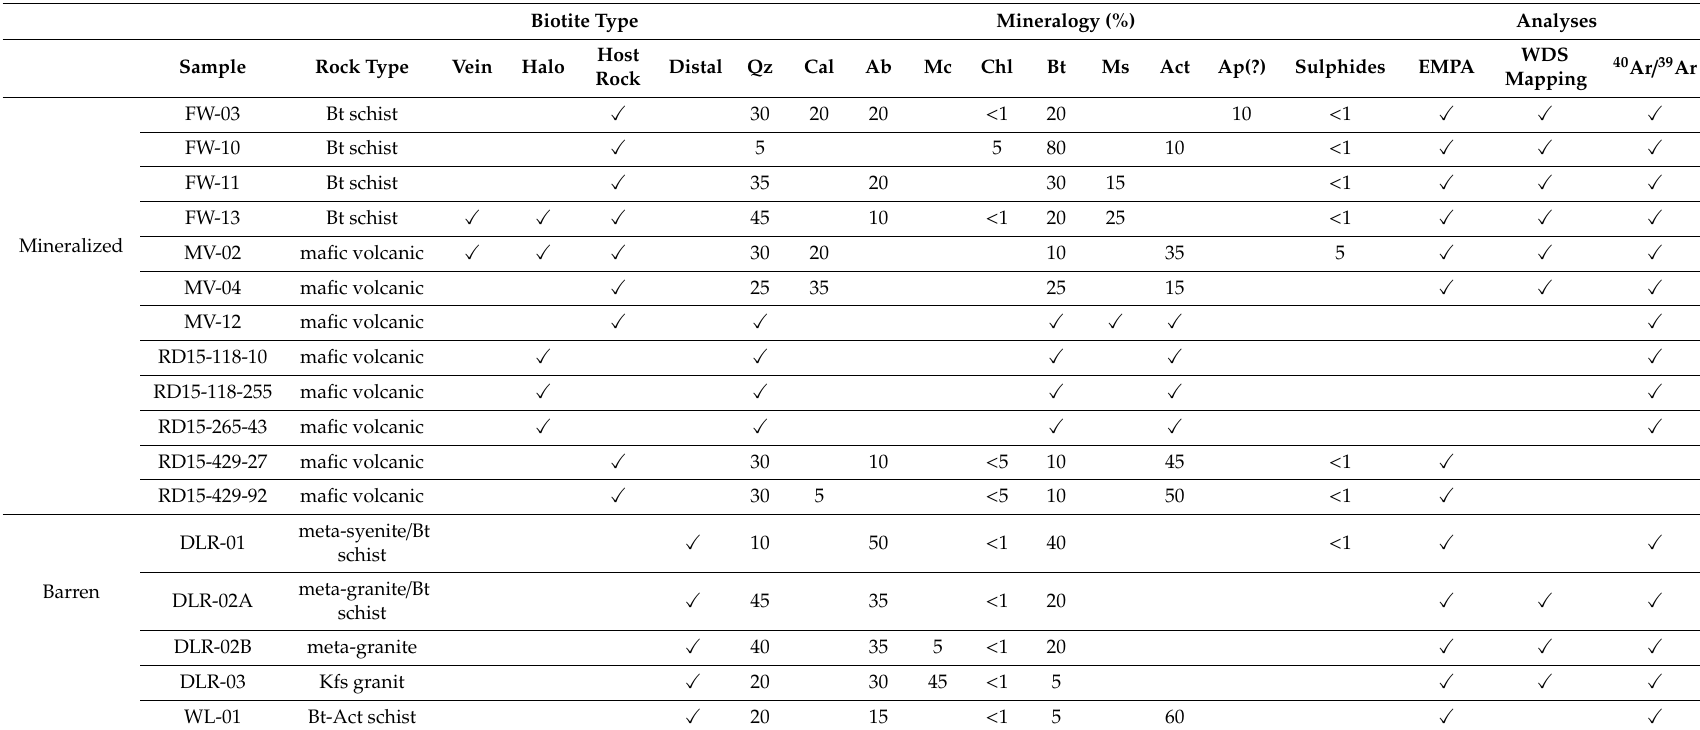
Table 1. Mineralogy, structural position, and conducted analyses of each sample from Detour Lake deposit. Biotite